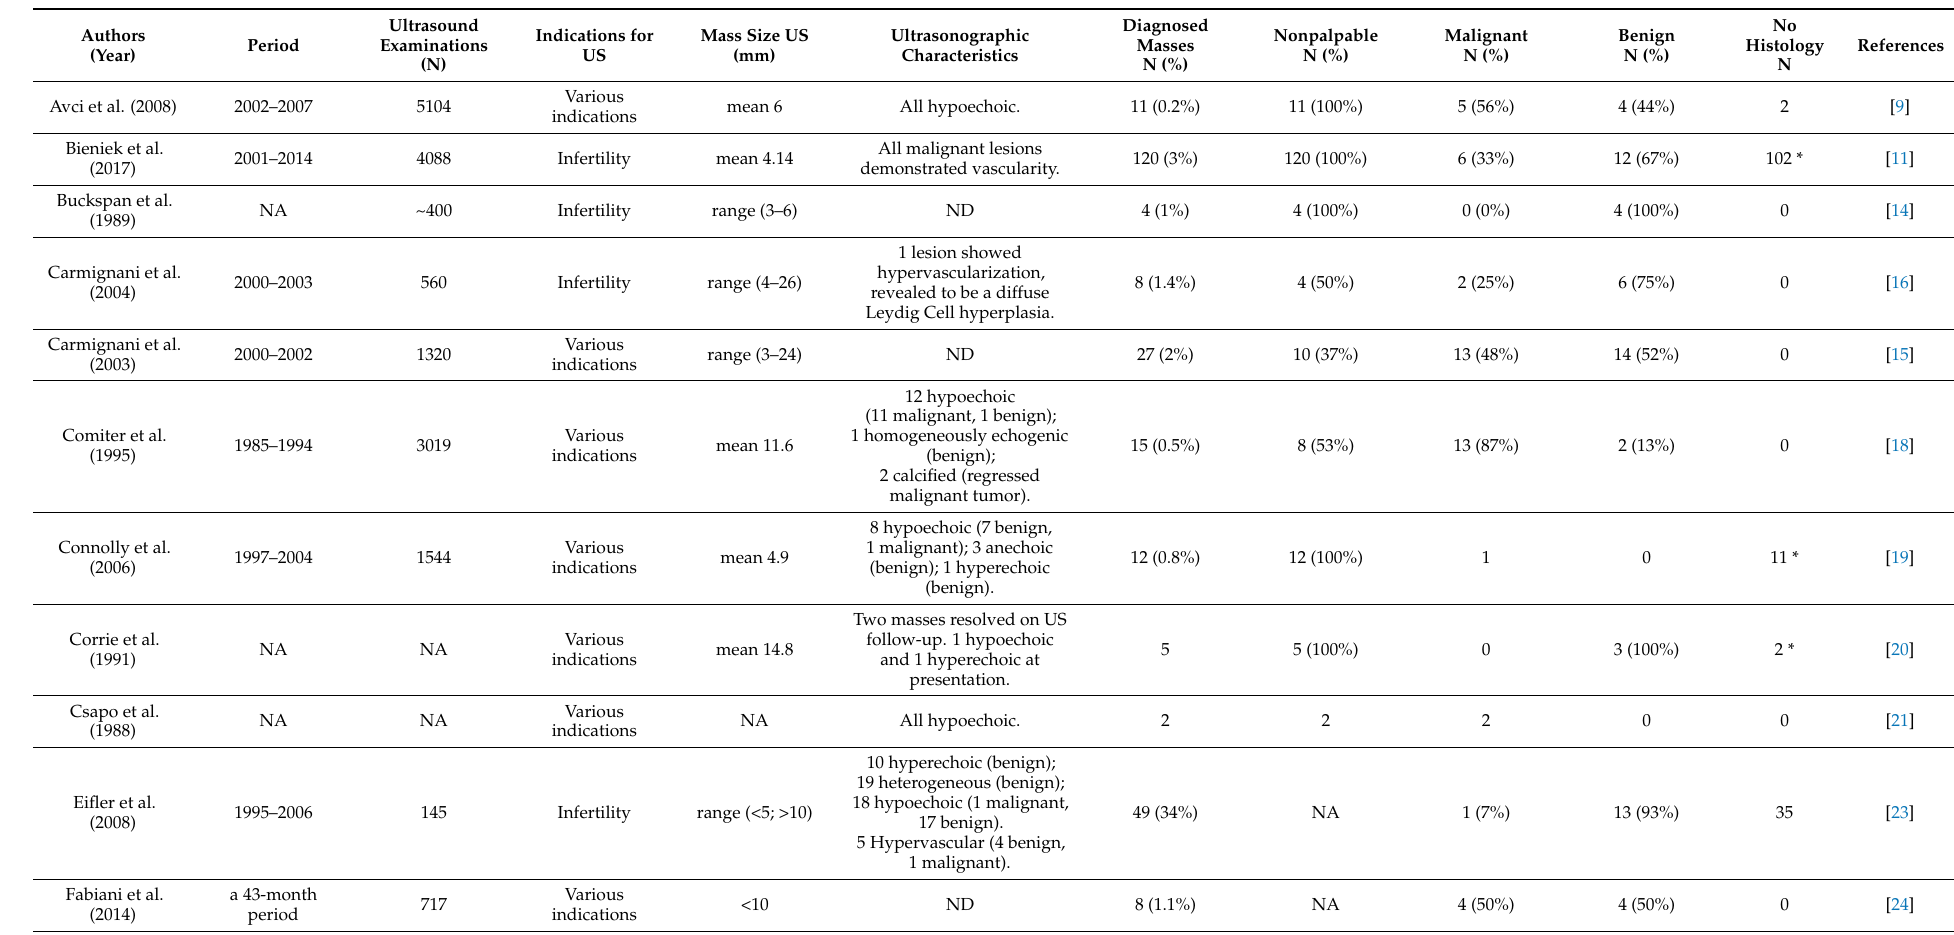
Table 1. Prevalence of nonpalpable testicular masses detected on US for several